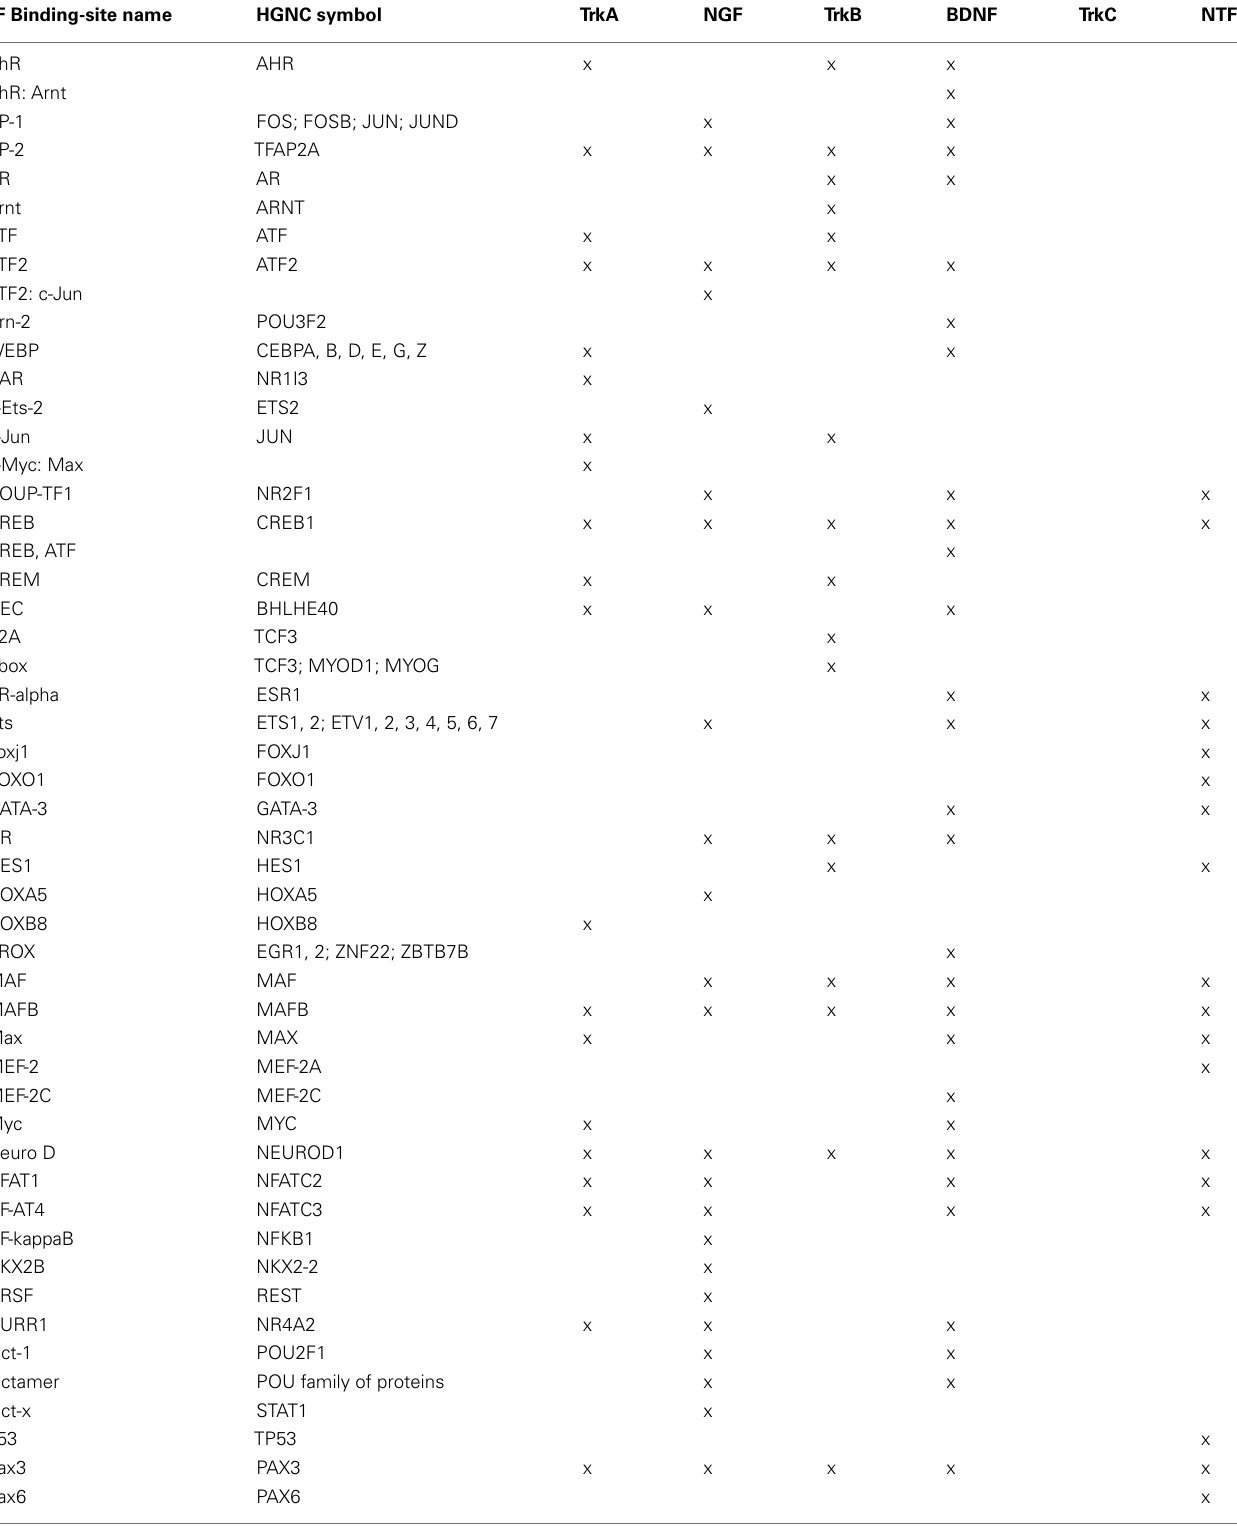
Table 6 |Transcription factor binding sites for neurotrophin and trk receptor genes. TF Binding-site